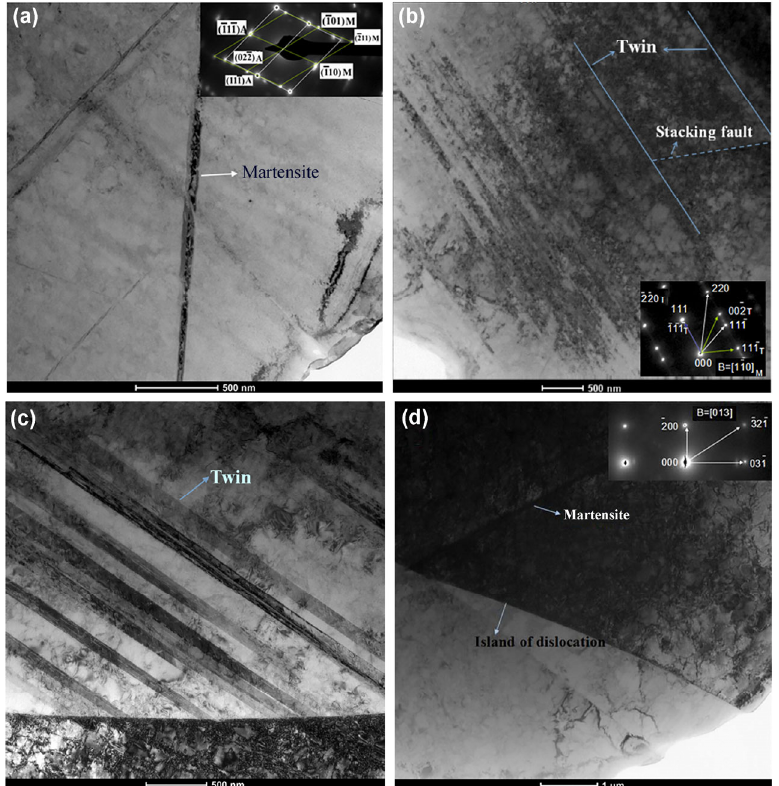
Fig. 7 The TEM results of the worn surface: (a) and (b) are the sample tested at 1.5 J impact energy; (c) and (d) are the sample tested at 3.5 J impact